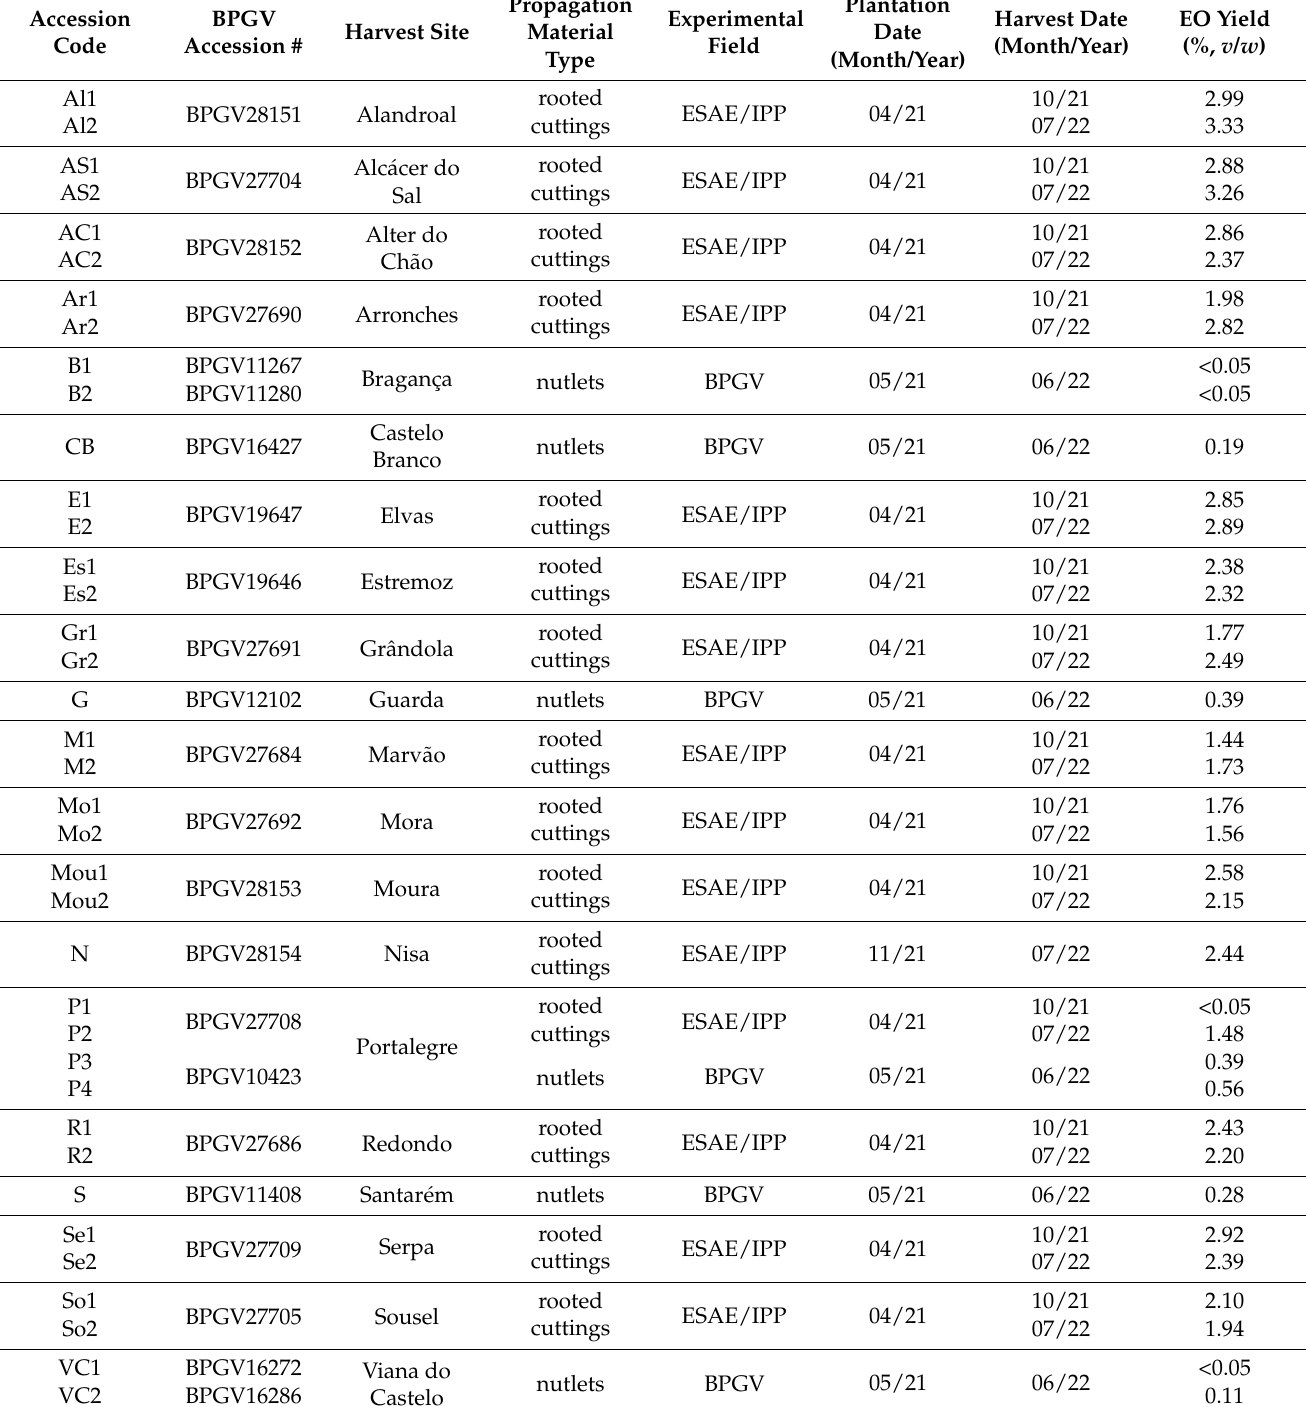
Table 1. Data on Origanum vulgare subsp. virens accessions studied, their codes, harvest site, type of propagation material, experimental field of growth, plantation and harvest dates and EO